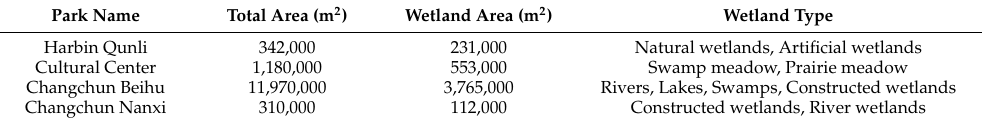
Table 1. Basic information about the four wetland